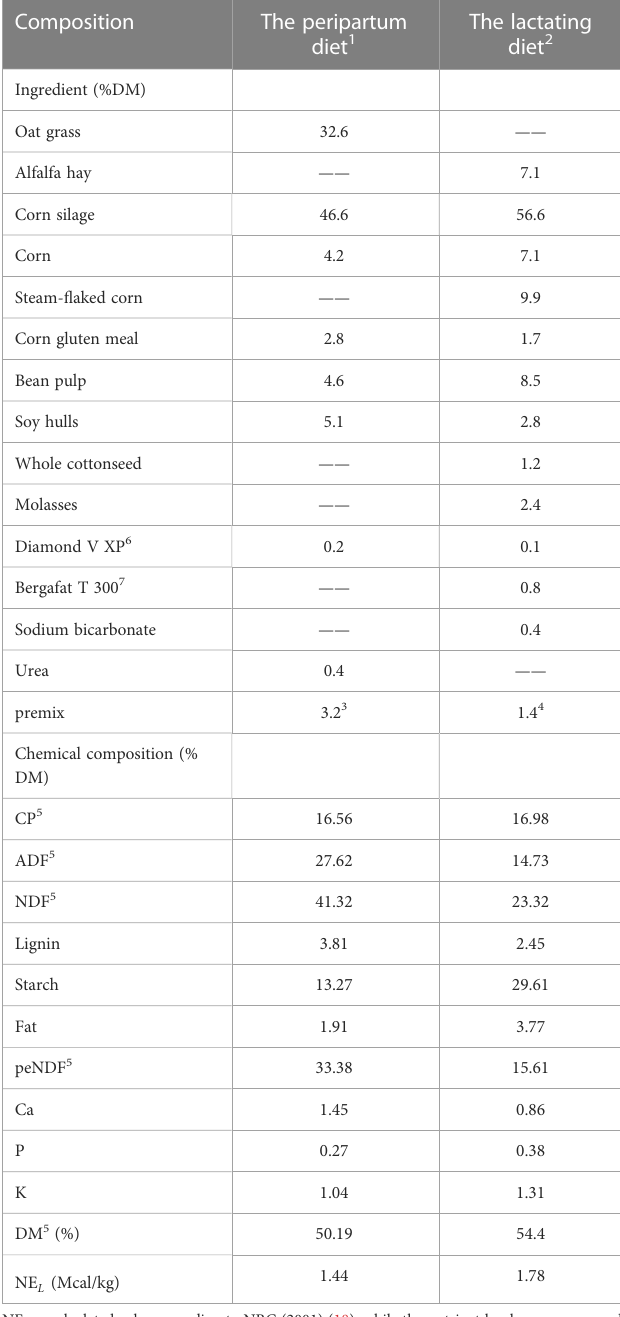
TABLE 1 Ingredient and chemical composition of the